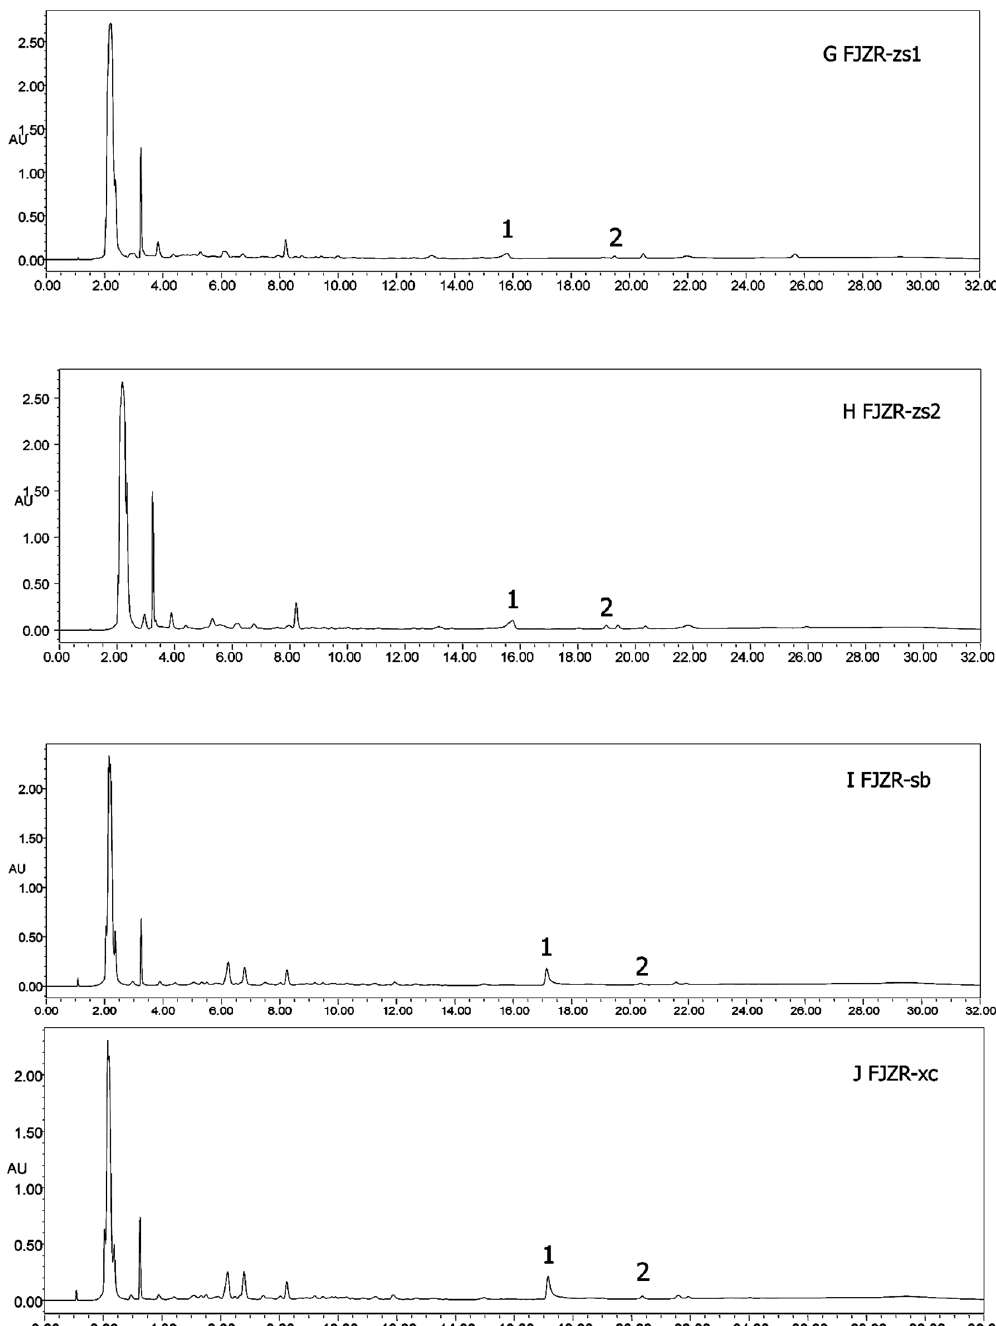
Figure 6. HPLC chromatograms of all samples (A–J). ( 1 ) Heterophyllin B, ( 2 ) heterophyllin A.